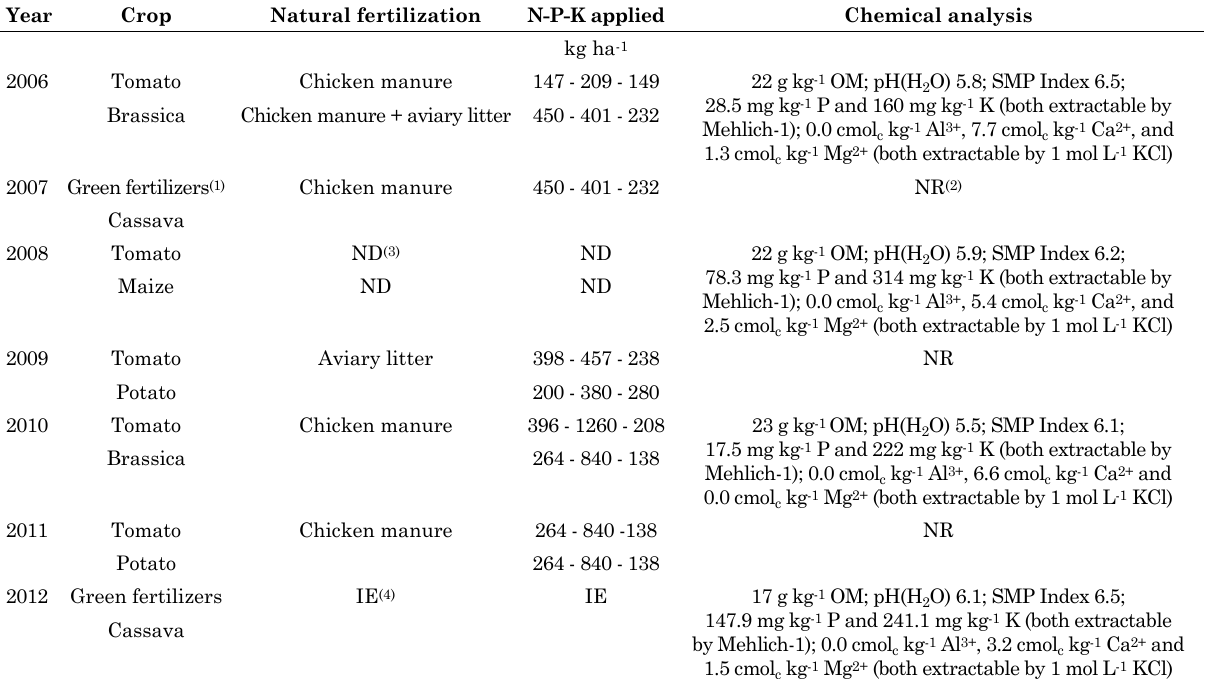
table 1. history of the experimental area, information about previous crops, fertilization and physical-chemical analysis of the Argissolo Vermelho-Amarelo